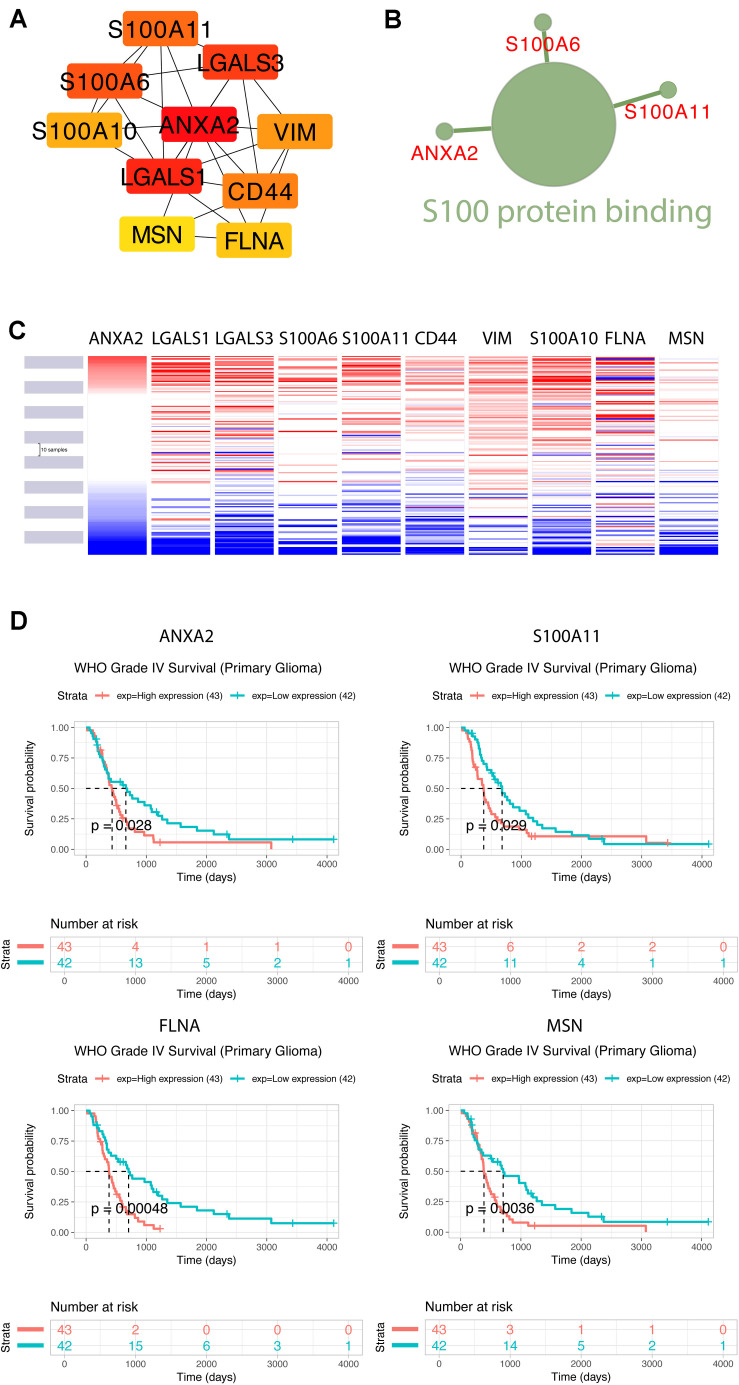
Construction of TUBB6 co-expression genes and analysis of hub genes. (A) The hub genes of TUBB6 co-expressed genes were characterized using cytoHubba. (B) The biological process analysis of hub genes was performed using ClueGO (q-value < 0.05). (C) The hierarchical clustering of hub genes was constructed using the UCSC online database. (D) Over survival analysis of hub genes in GBM which is derived on CGGA database (p-value < 0.05).